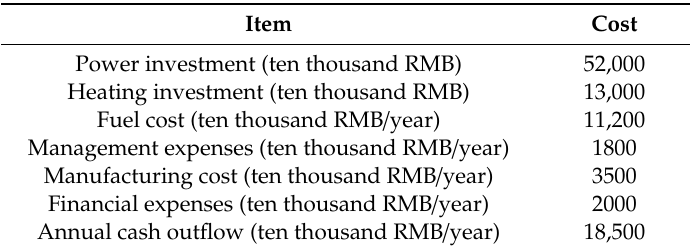
Table 3. List of investment and operating costs.